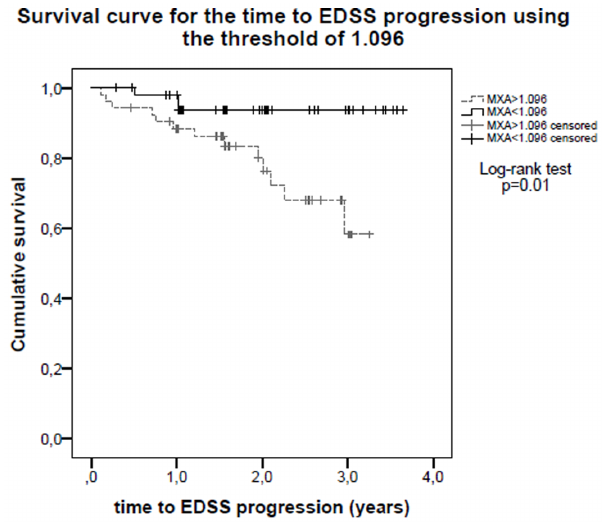
Figure 2. Survival curve for the time to EDSS progression using the 1.096 threshold. Patients belonging to the low-MxA group (MxA , 1.096) showed a significantly longer time to increase by one point on the EDSS scale (p=0.01). doi:10.1371/journal.pone.0112758.